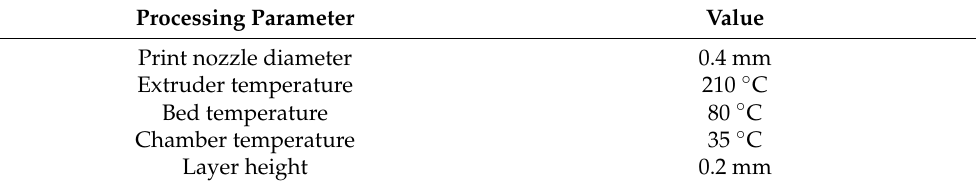
Figure 1. ( a ) Raw material images and the hybrid powder after mechanical milling; ( b ) extruded filaments of TPU/Cu/MWCNT composites before 3D printing; and the 3D-printed test specimen for ( c ) interrogation of the electrical conductivity and ( d ) compression test. Table 1. 3D printing parameters to fabricate 3D-printed TPU/Cu/MWCNT composites.